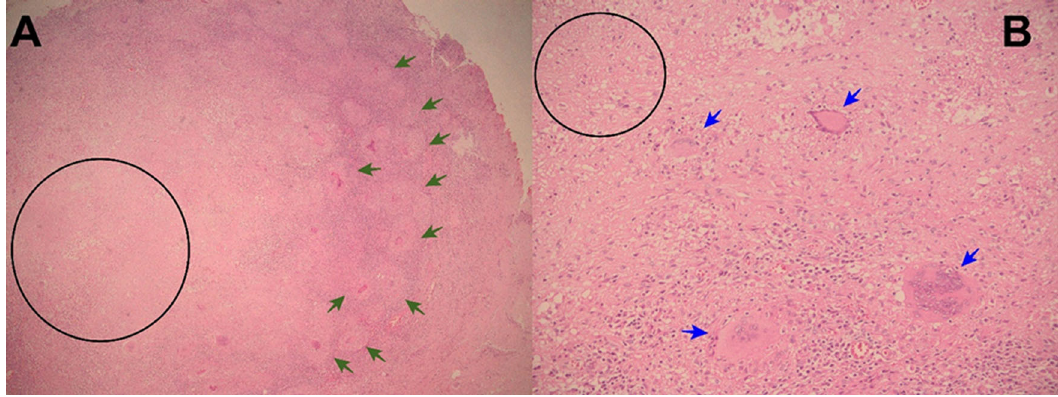
Figure 2. A: Electronic microphotography (x40) showing parietal peritoneum with chronic granulomatous inflammation, granulomas (green arrows), and caseous necrosis (black circle). B: Electronic microphotogra- phy (x40) showing Langhans multinucleated giant cells (blue arrows); caseous necrosis (black circle). Ziehl- Neelsen smear for Acid Fast Bacilli was negative.